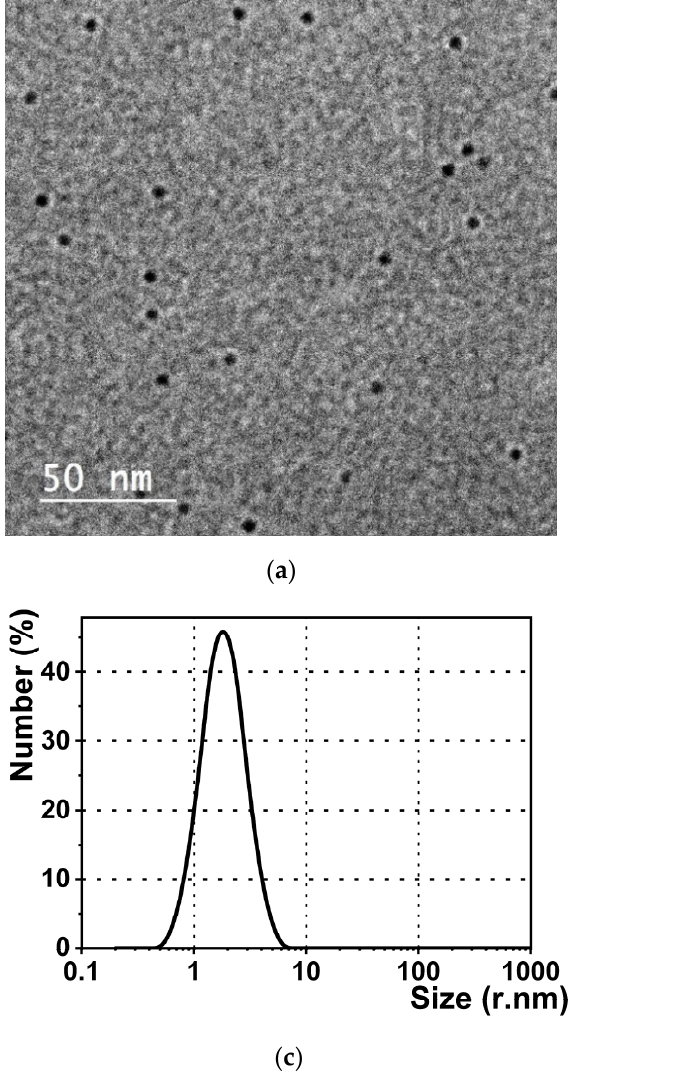
Figure 1. ( a ) The absorption spectra of pepsin and Pep-CuNCs; ( b ) The excitation and emission spectra of Pep-CuNCs.